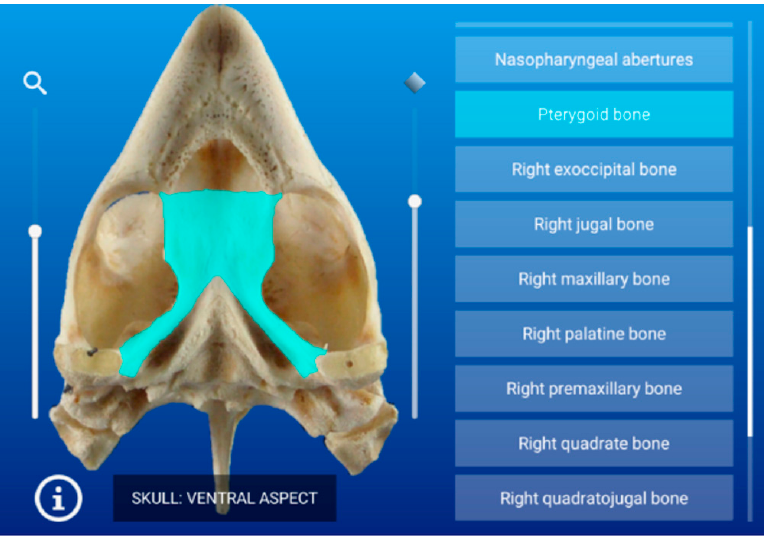
Figure 3. The menu navigation bar is shown for all the labels of a bone image. We created a double interaction function so if the user selects over the label, the mask image is shown over the left image and if the user moves the mouse over that region, the scroll will look up that mask label and highlight it.